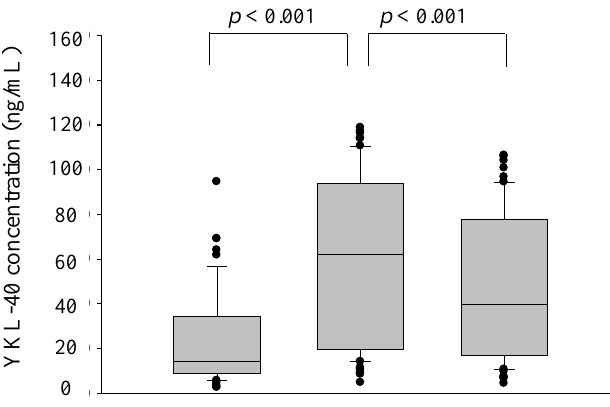
Figure 1. Levels of plasma YKL-40 in 61 patients with community-acquired pneumonia and 60 control patients based on ELISA analysis. p <